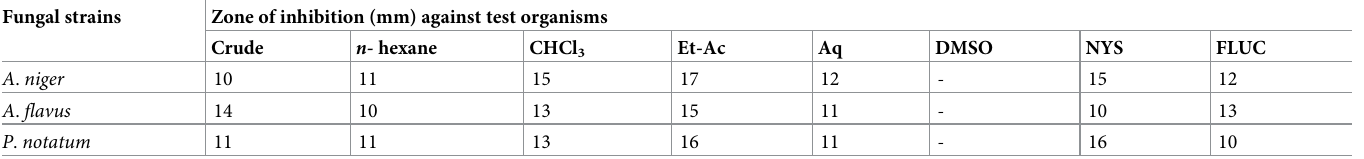
Data is presented as mean value of three determinations